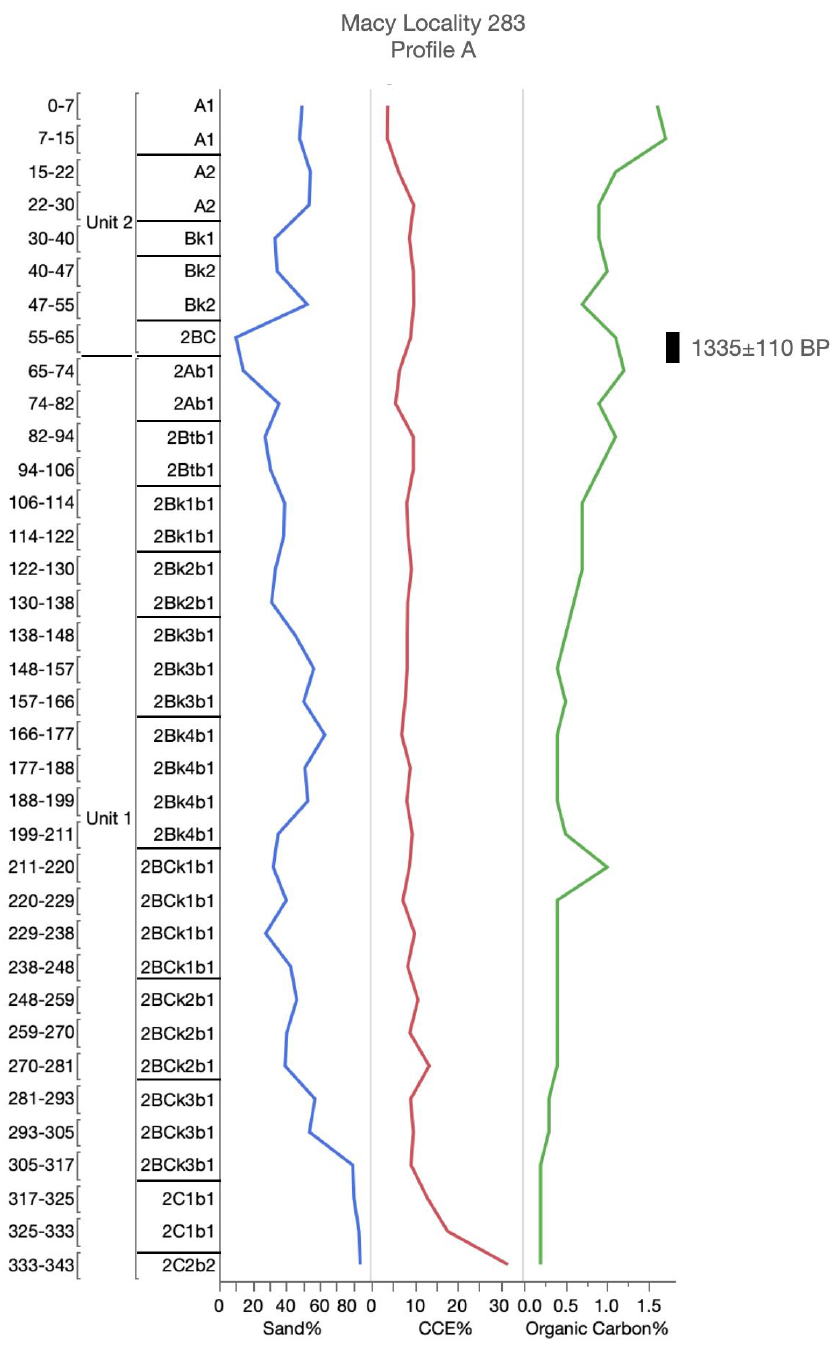
Figure A10. Accepted radiocarbon ages and soil and sediment analysis at Macy Locality 283, Profile A—Post research area, northwest, Texas. CCE = calcium carbonate equivalence.